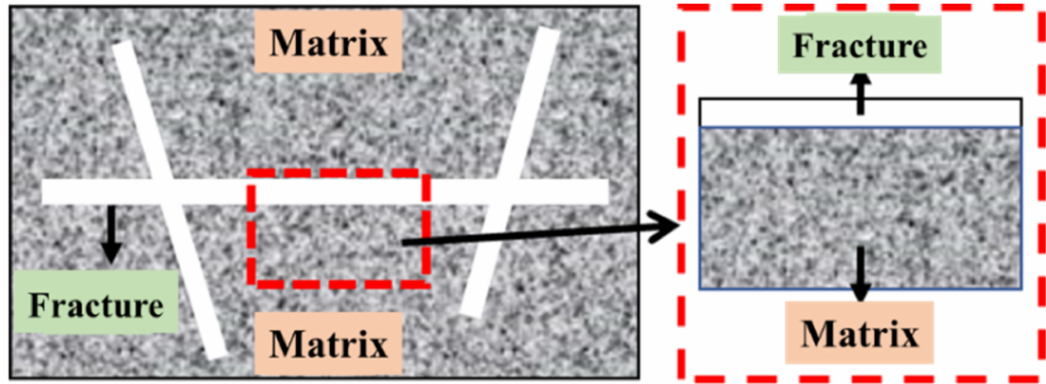
Figure 1. Schematic diagram of the matrix-fracture